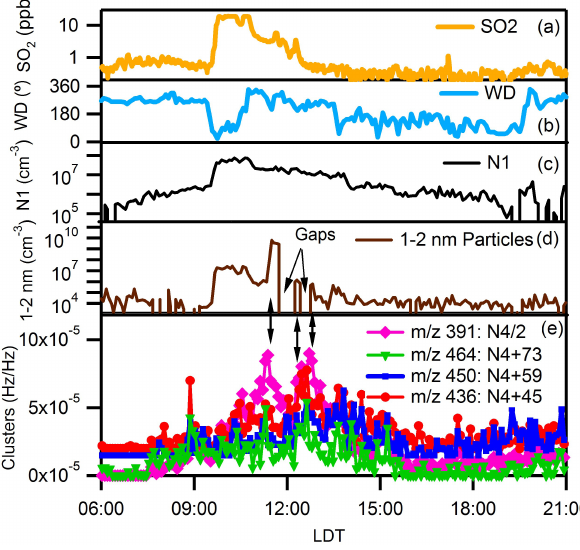
Fig. 7. Ambient measurements on 1 September 2010 at the NCAR Foothills Laboratory in Boulder, Colorado: (a) concentration of SO 2 (yellow); (b) wind direction (WD, in degree) (light blue); (c) concentration of monomers in logarithm scale (N1 in cm − 3 ) (black); (d) concentrations (uncorrected) of nanoparticles in a size range of 1–2nm measured from DEG SMPS(dark purple); (e) sig- nals of the sulfuric acid-amine clusters (N4+45/59/73) and sulfuric acid tetramer (N4, shown in half intensity), divided by the reagent ion (i.e. m/z 125). The m/z 436 and 450 curves were shifted up by 2 × 10 − 5 and 1.5 × 10 − 5 respectively for easier view. LDT is local daylight saving